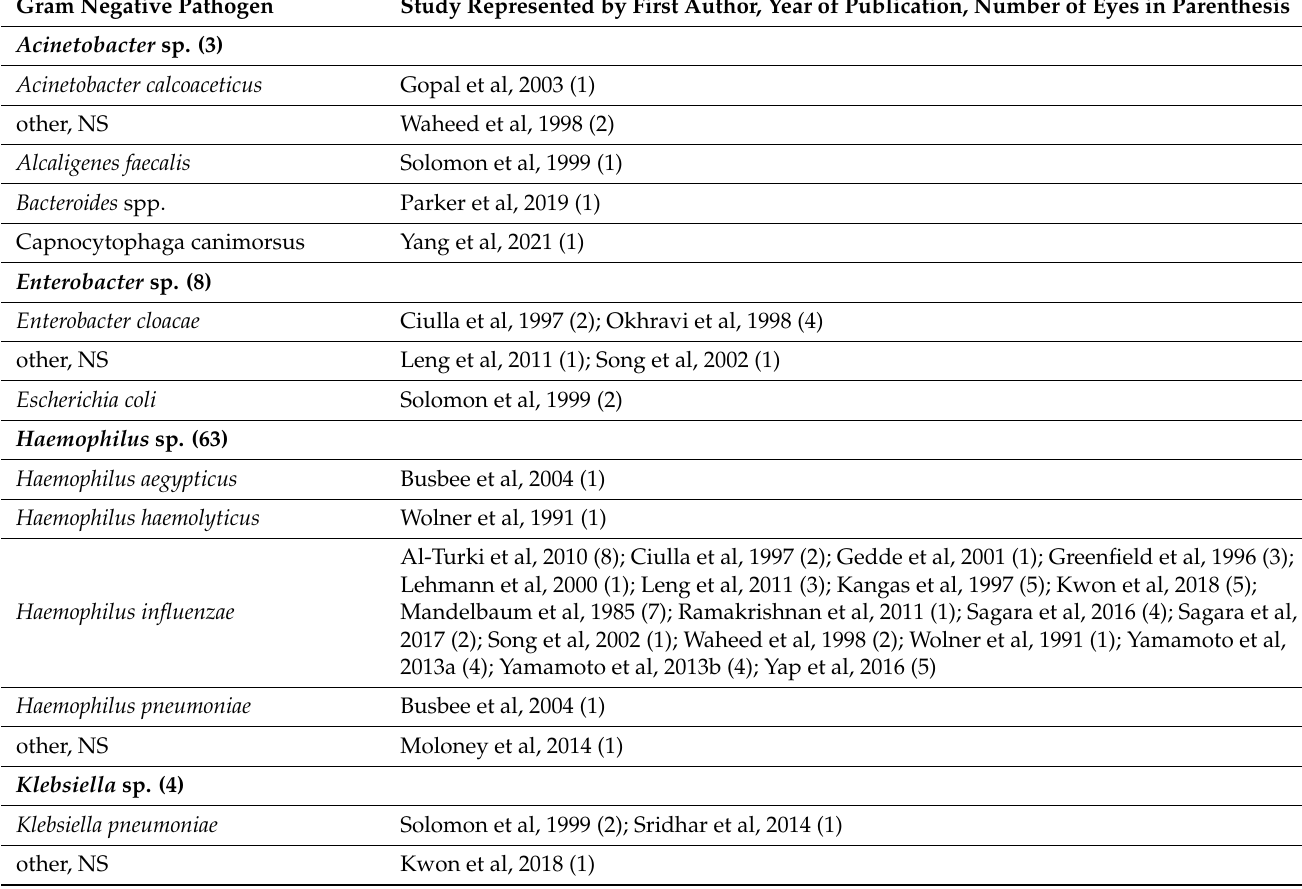
Table 2. Gram-negative pathogens causing